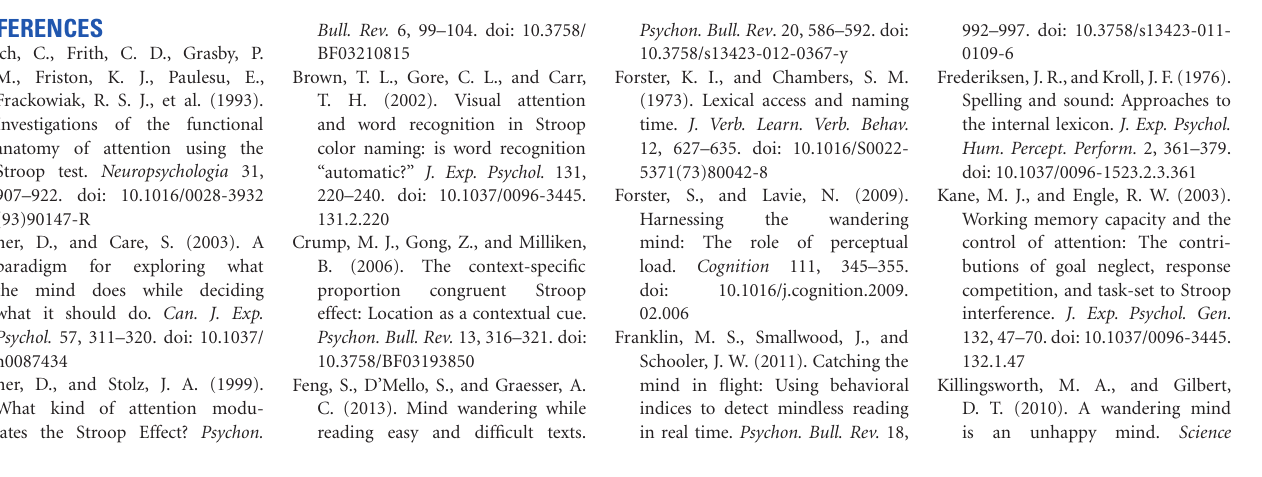
resources needed for reading. Adistribution point to the left of the one shown would result in primary task performance costs, whereas a distribution point tothe right ofthe one shown wouldresult inadecrease in mind wandering with no appreciable benefits to primary task